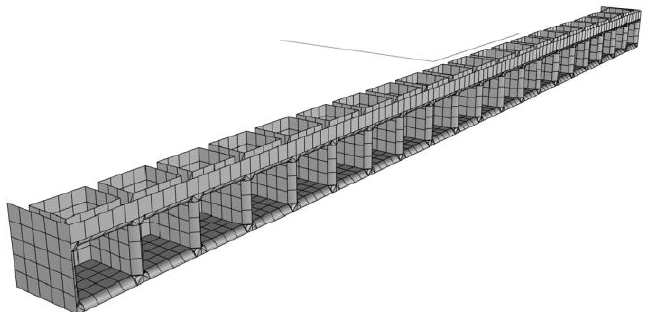
Figure 3. Panel mesh of the KNSwing used in the BEM code for estimation of hydrodynamic coefficients.